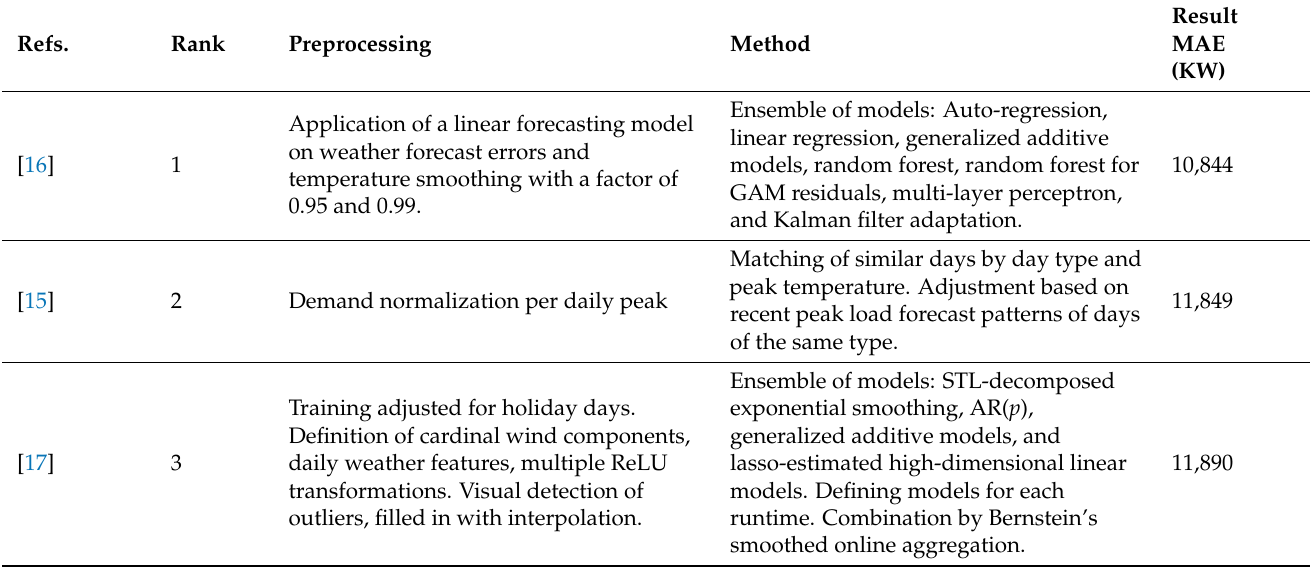
Table 1. Methods and Results from the Works Participating in the “IEEE Dataport Competition Day-Ahead Electricity Demand Forecasting: Post-COVID